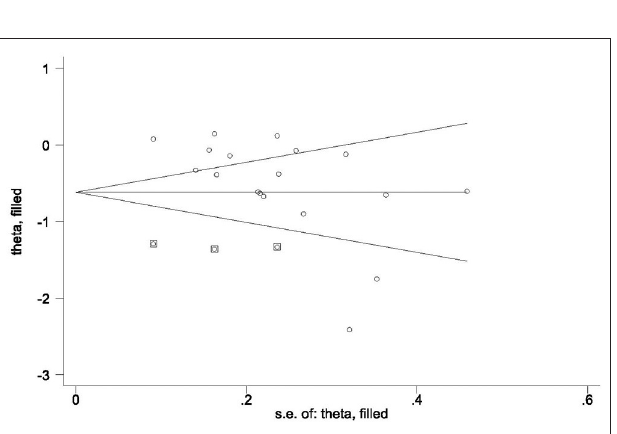
FIGURE 3 | Meta-analysis results for the association between natural and built environment exposure on negative affect.